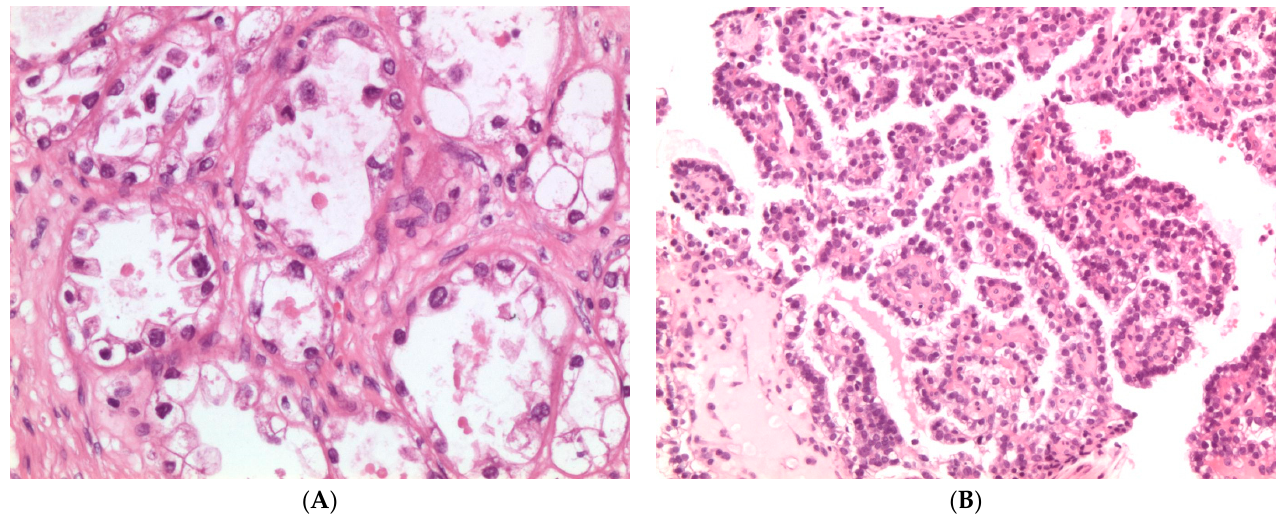
Figure 4. ( A ) Histologic appearance of clear cell carcinoma with tubulocystic pattern, tumor cells are polygonal to cuboidal and flattened with clear cytoplasm; (hematoxylin and eosin, H&E, ×200); ( B ) Papillary pattern shows small and regular papillae, frequently hyalinized (hematoxylin and eosin, H&E ×100).